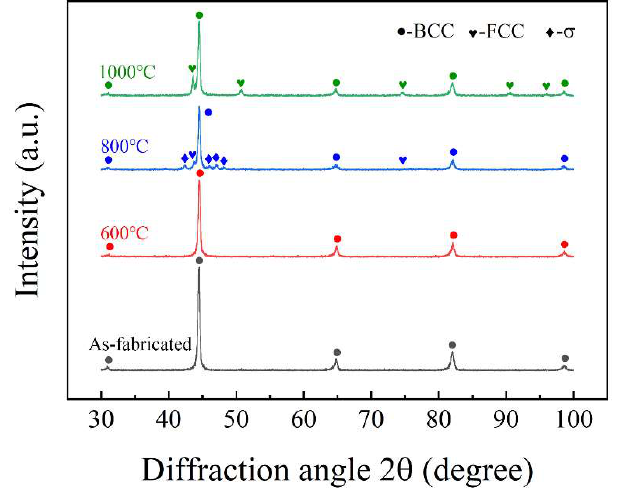
Figure 2. XRD results of the AlCoCrFeNi components before and after high-temperature treatment.